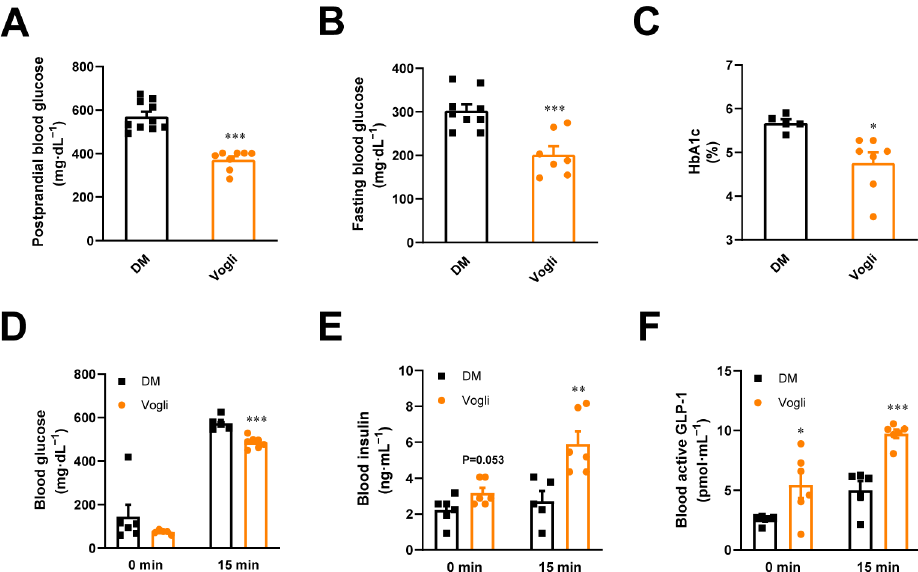
Figure 1. Voglibose ameliorates glucose metabolism in KKAy mice. ( A ) Fasting blood glucose. ( B ) Postprandial blood glucose. ( C ) HbA1c. ( D ) Blood glucose. ( E ) Blood insulin level at 0 and 15 min in the oral glucose-stimulated insulin secretion test. ( F ) Blood active GLP-1 level at 0 and 15 min in the oral glucose-stimulated GLP-1 secretion test. Data are expressed as the mean ± standard error of the mean (SEM) and individual data was shown in square (DM) and circle (Vogli), n = 5–10. * p < 0.05, ** p < 0.01, *** p < 0.001 vs. DM. DM, diabetic model group; Vogli, voglibose-treated group.